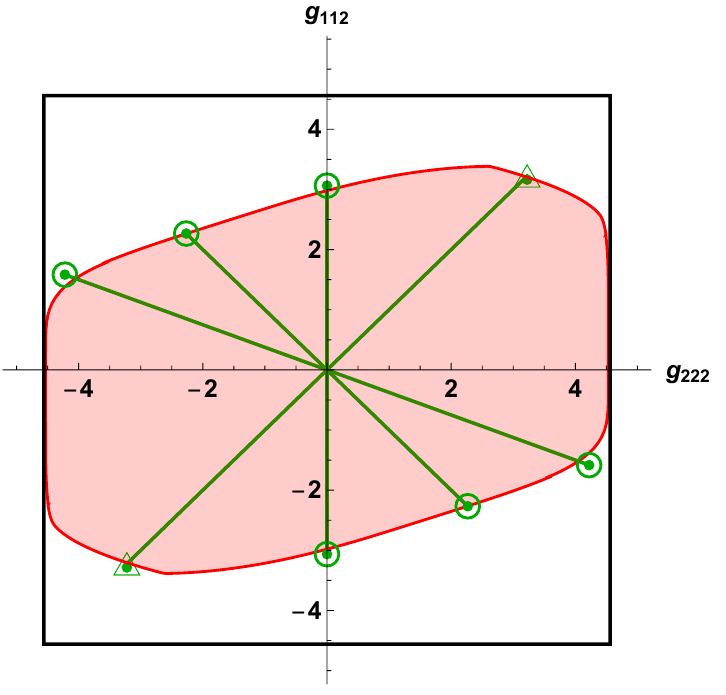
Figure 11. Overlaid on a repetition of (cid:12)gure 9, the green data points show the maximal values of g 112 as derived from the QFT in AdS analysis for (cid:12)xed values of (cid:11) = g 222 =g 112 . (The green straight j j lines then indicate the allowed range in coupling space.) The conformal bootstrap agrees very well with the S-matrix bootstrap. The point with (cid:11) = 1 is point A in (cid:12)gure 9 which corresponds to the (cid:0) 3-state Potts model, which ‘emerges’ here from the conformal crossing equations in one